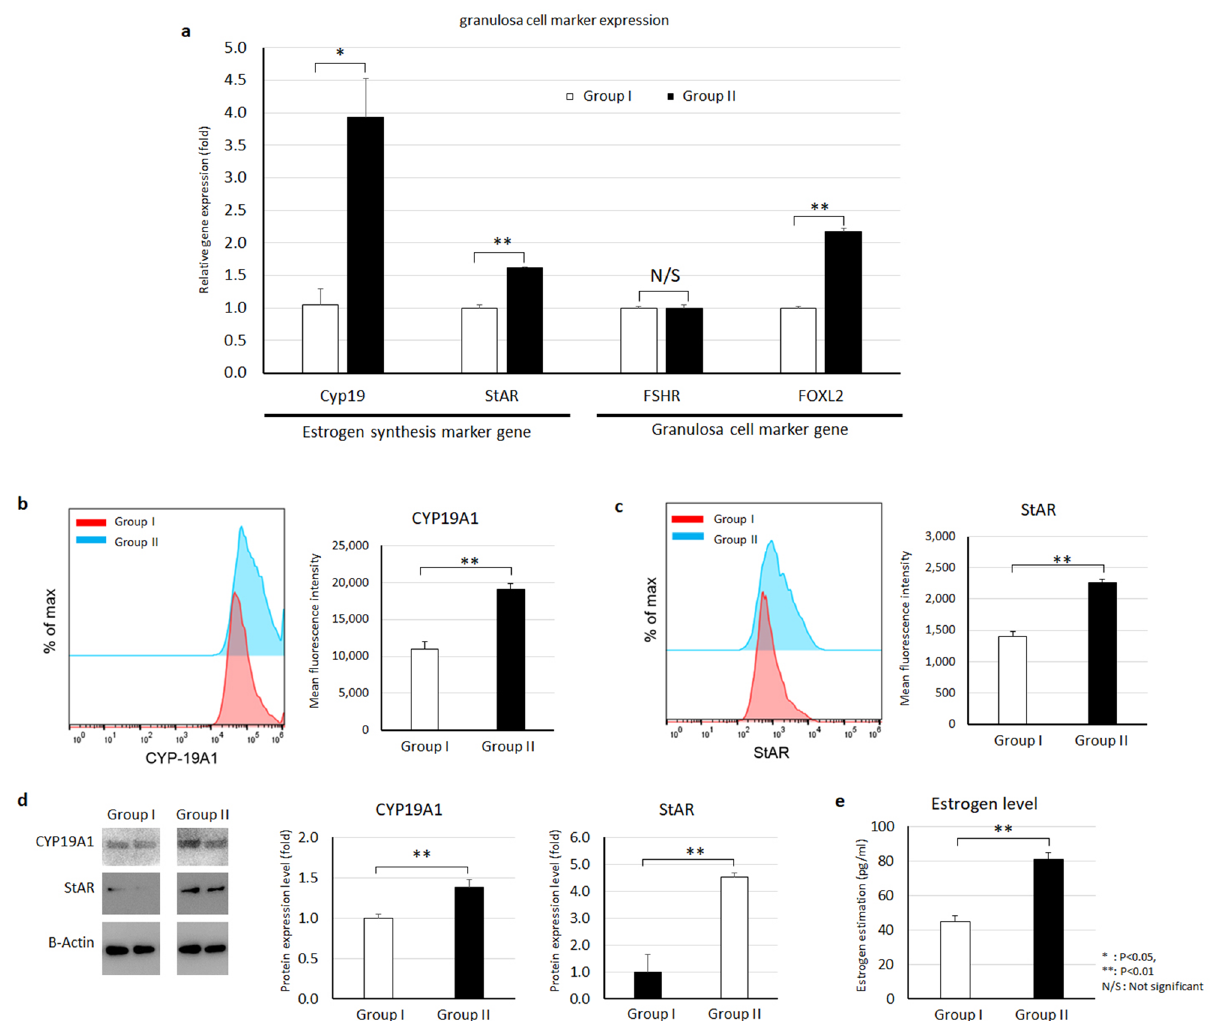
Figure 3. hMSC CM stimulates steroidogenesis by human granuloma cells. ( a ) RT-PCR analysis of granulosa cell marker gene expression in control HGrC1 (Group I) and hMSC CM-treated HGrC1 (Group II). ( b – d ) Analysis of estrogen synthesis pathway proteins CYP19A1 (aromatase) and StAR. CYP19A1 protein expression ( b ) and StAR protein expression ( c ) by flow cytometry. ( d ) CYP19A1 and StAR protein expression by immunoblot. ( e ) Analysis of estrogen levels in HGrC1 cell-cultured conditioned media. Two biological replicates per group were analyzed in duplicate (* P < 0.05, ** P < 0.01, N/S not